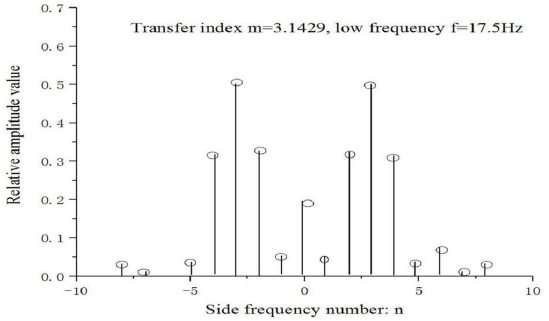
Figure 1: Theoretical amplitude spectrum of domestic 18 information